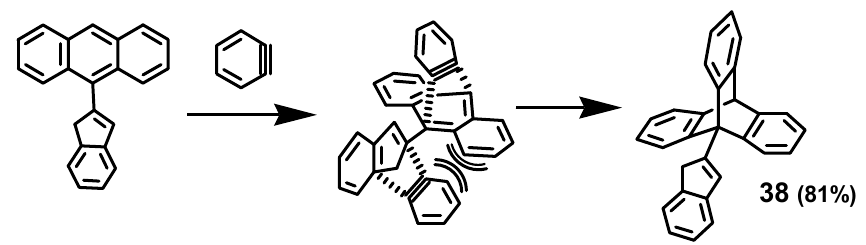
Figure 8. Molecular structure of benzyne adduct 37 .